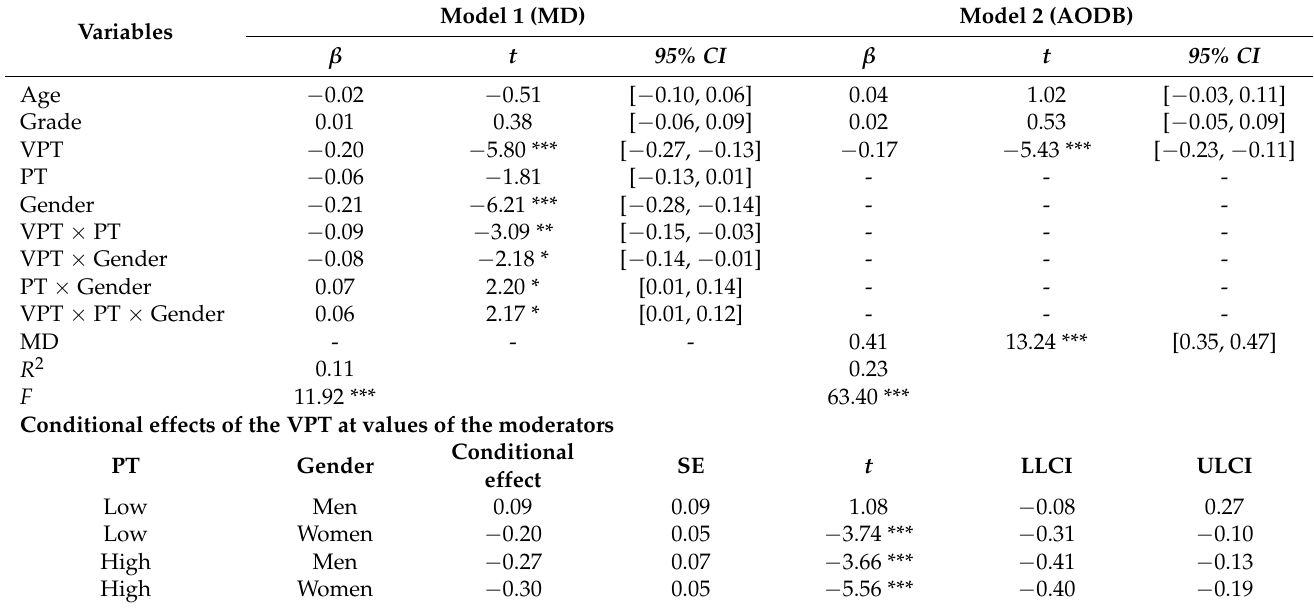
Table 4. Testing the moderated moderated-mediation